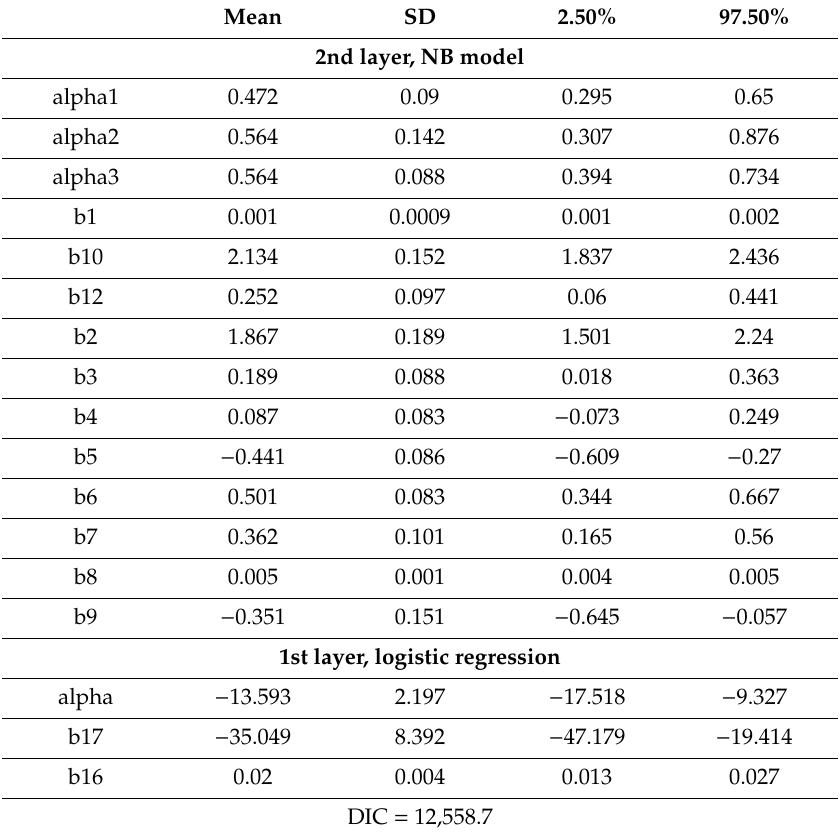
Table 5. Estimation results of two-layer model, with NB distribution for the second